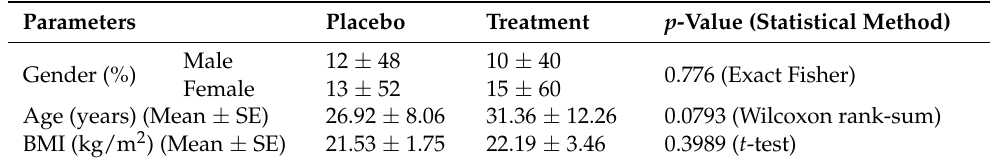
Table 1. Grouping and demographic data.